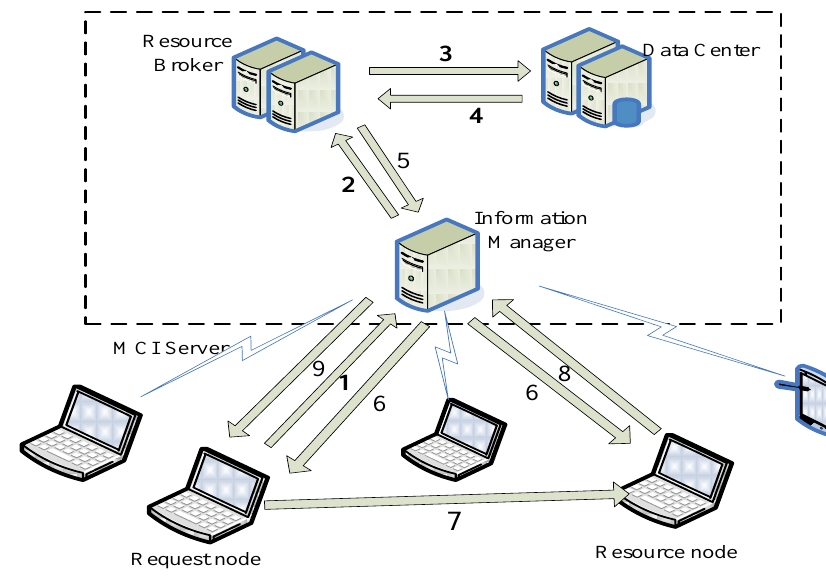
Figure 3. The procedure of the system